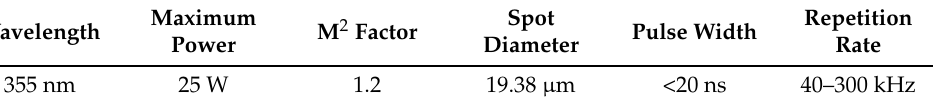
Table 2. Main parameters of laser generator.